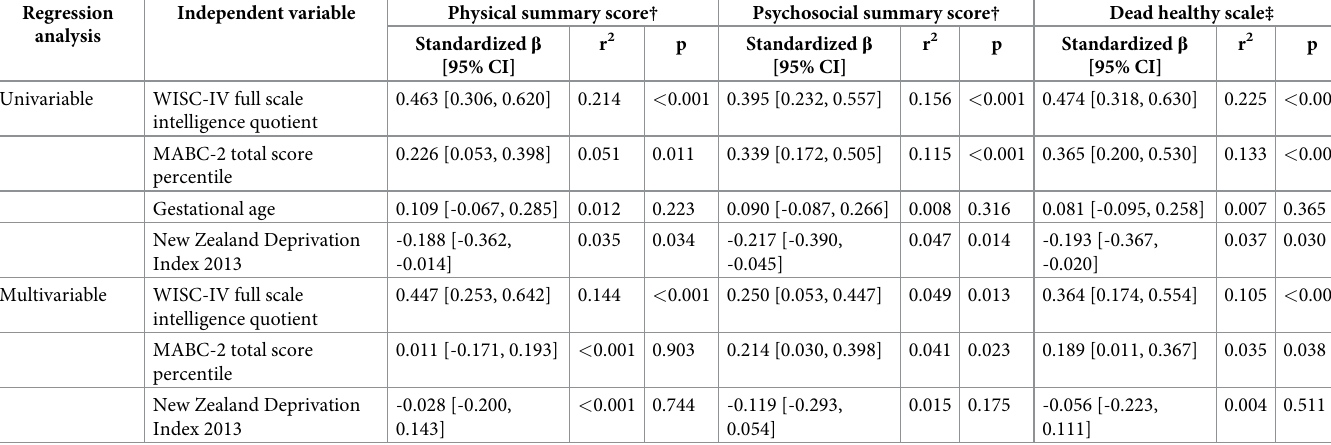
Table 4. Relationships between measures of health-related quality of life and full-scale intelligence quotient, Movement Assessment Battery for Children total score percentile, gestational age, and socio-economic deprivation. Regression